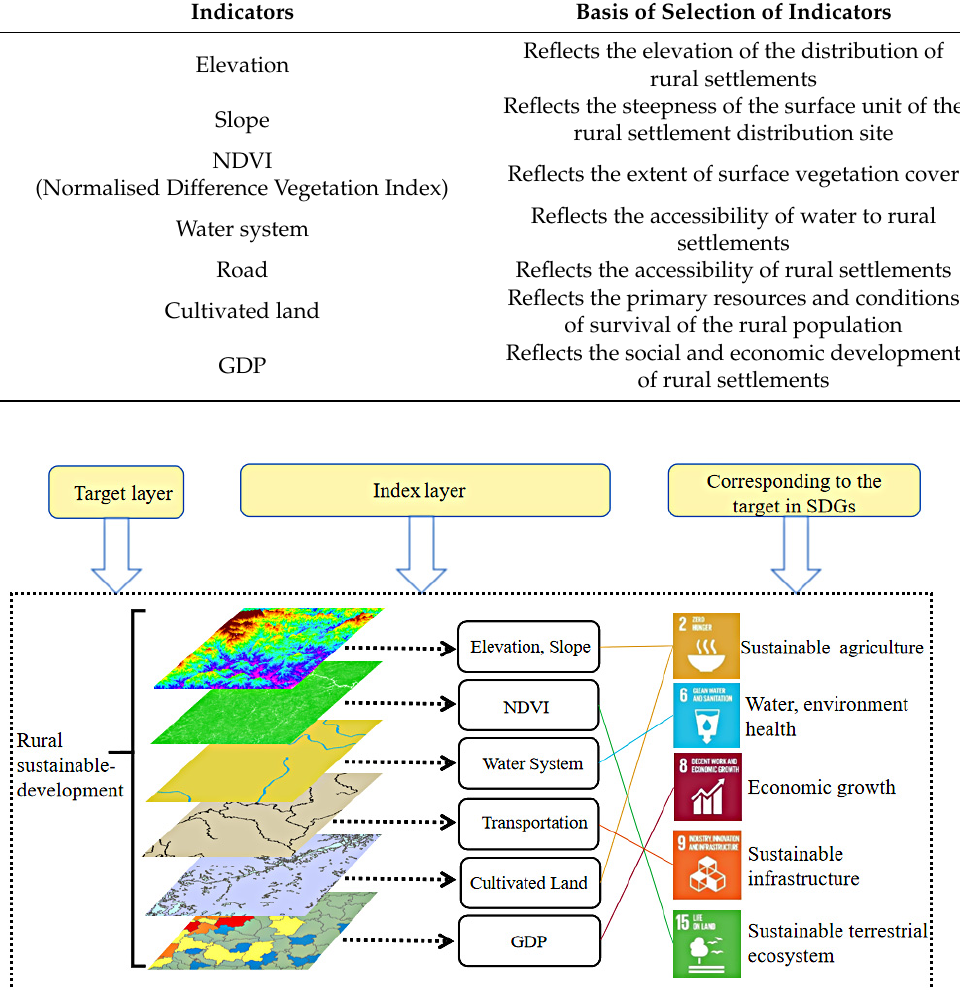
Figure 2. Evaluation system for the sustainable development of rural settlements in the Miaoling Mountains. (SDGs: Sustainable Development Goals).